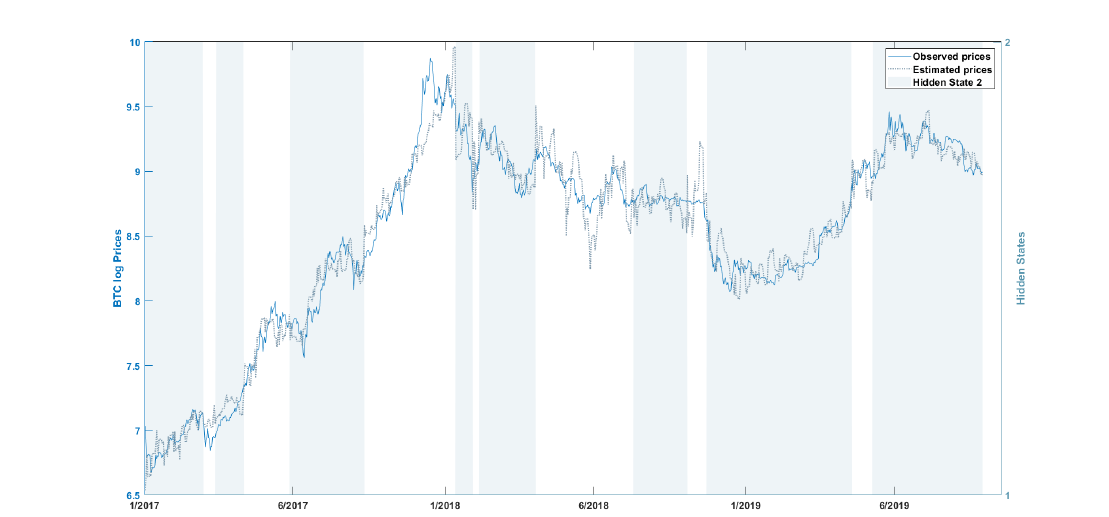
Figure 3. Logarithmic ETH price series (blue line) and in-sample estimated logarithmic ETH price series for the period 6/2016–5/2019 (gray dotted line). Shaded bars mark times with hidden state 1 (smoothed probability above 0.5). The model accounts for the heteroskedasticity of the series.